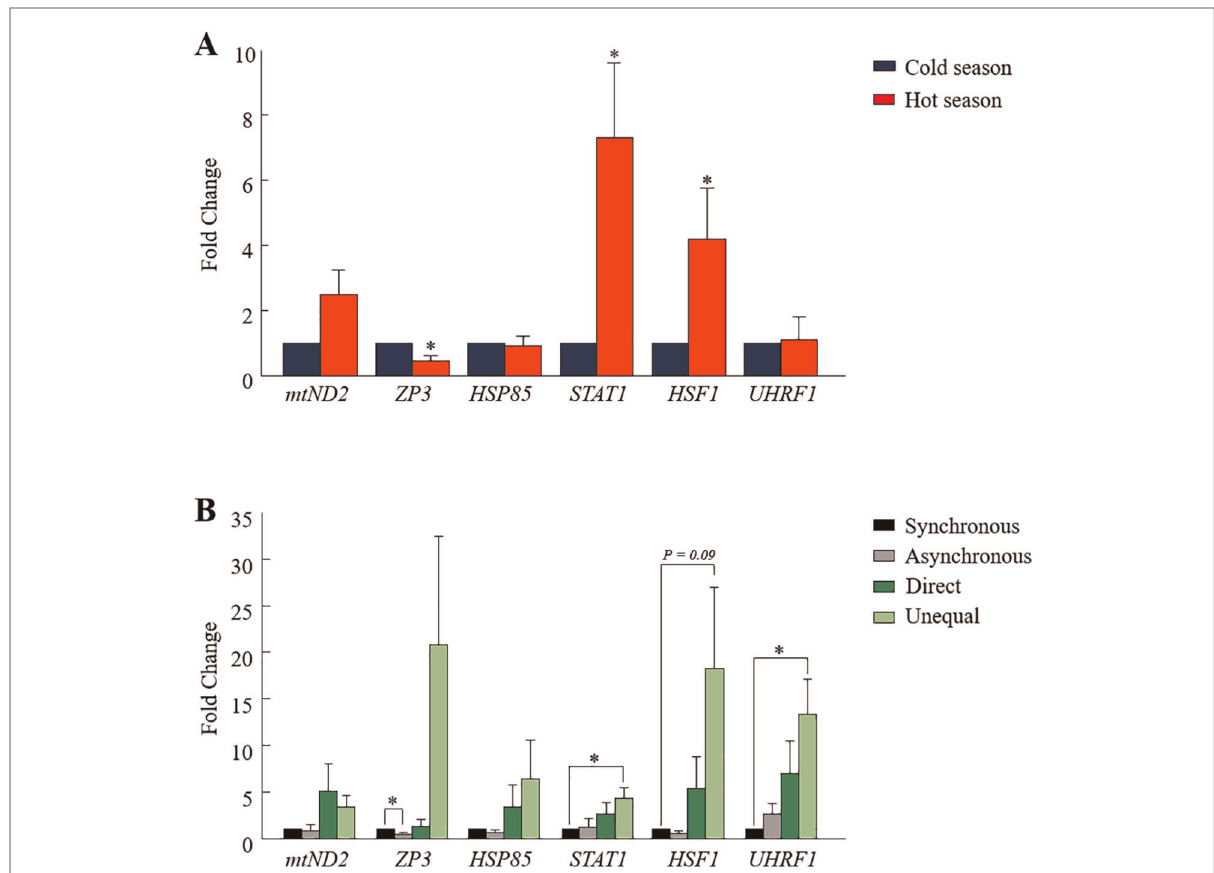
FIGURE 4 Gene expression analysis in blastocysts. ( A ) Cumulus-oocyte complexes were in-vitro - matured for 22 h and then fertilized. Putative zygotes were then in-vitro -cultured in a conventional incubator for an additional 190 h to allow blastocyst formation. The pools of blastocysts ( n =3 blastocysts per sample; 10 samples for each season) were collected and their mRNA was extracted for RT-qPCR, based on six selected genes ( mtND2, ZP3, HSP85, STAT1, HSF1, and UHRF1) . Presented is the fold change calculated by the 2 − ΔΔ CT method, normalized against the reference genes YWHAZ and against the cold season (expression was set to 1). ( B ) Cumulus-oocyte complexes were in-vitro -matured for 22 h and then fertilized. Putative zygotes were in-vitro -cultured in a time lapse system for an additional 190 h to allow blastocyst formation. Blastocysts that developed from the synchronously-, asynchronously-, directly-, and unequally cleaved embryos were individually collected, and their mRNA was extracted for RT-qPCR. Gene expression was conducted based on six selected genes ( mtND2, ZP3, HSP85, STAT1, HSF1, and UHRF1). Presented is the fold change calculated by the 2 − ΔΔ CT method, normalized against the reference genes YWHAZ and against the synchronously cleaved embryo that developed in the cold season (expression set to 1). Data are presented as the means±SEM. * p